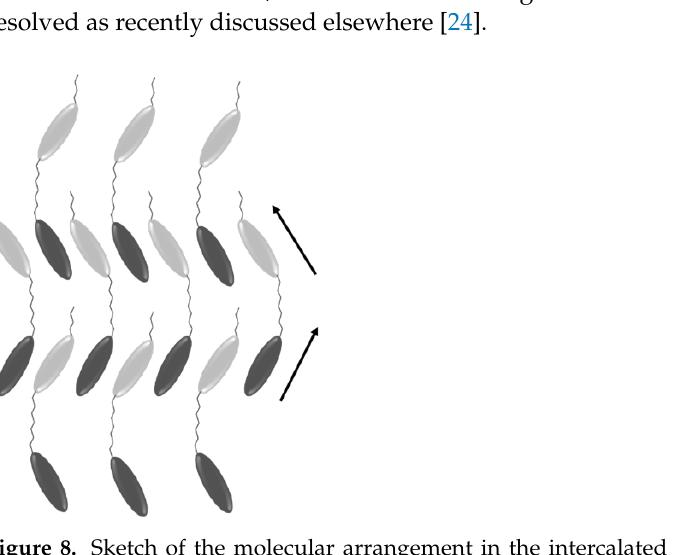
Figure 9. The dependence of the transition temperatures on the number of carbon atoms, m , in the terminal chain for the CBO5O. m series [18]. The broken line joins the melting points. Circles denote T NI ; triangles T NTBN ; squares T SmAN ; diamonds T SmCSmA .